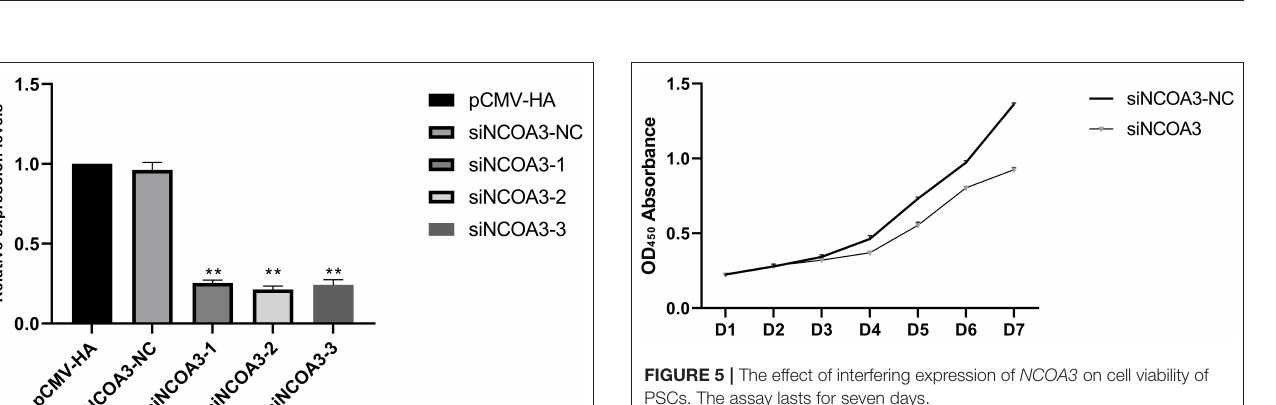
FIGURE 3 | The effects of overexpression of target gene on EdU staining, cell cycle and expression level of CyclinD1 . (A) The percentage of EdU-positive cells in NCOA3, DDR2 and RDX groups. (B) Effect of target gene on cell cycle. Cell samples from each group were collected at 48 h post-transfection. (C) Detection of mRNA expression level of CyclinD1 by qPCR. A value of p < 0.05 was considered statistically significant. ** p < 0.01, *** p < 0.001, **** p < 0.0001.